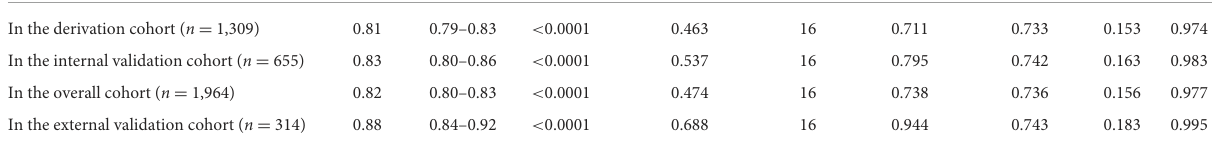
TABLE 3 Discrimination of ICH-DVT with regard to in-hospital DVT after